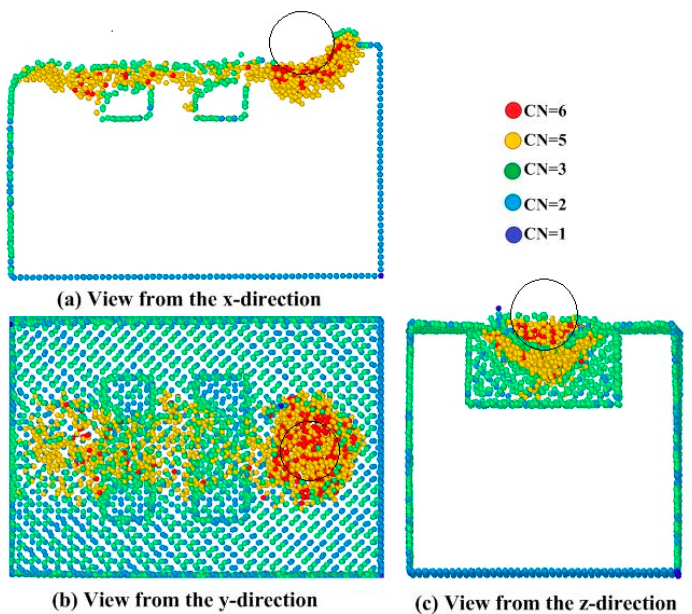
Figure 9. A diagram of the cross-sectional views of the atomic positions with various views at the polishing distance of 14.2 nm. CN, coordination number.